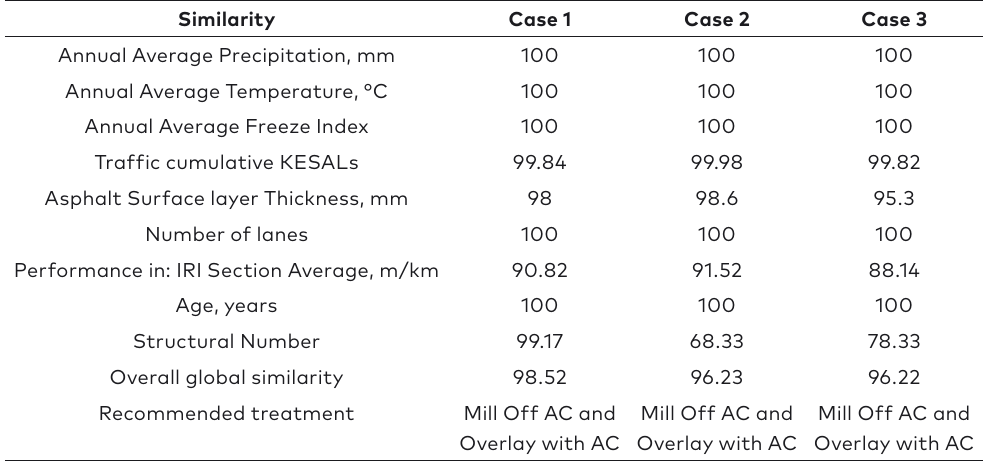
Table 9. Pavement sections with the maximum similarity to the query case